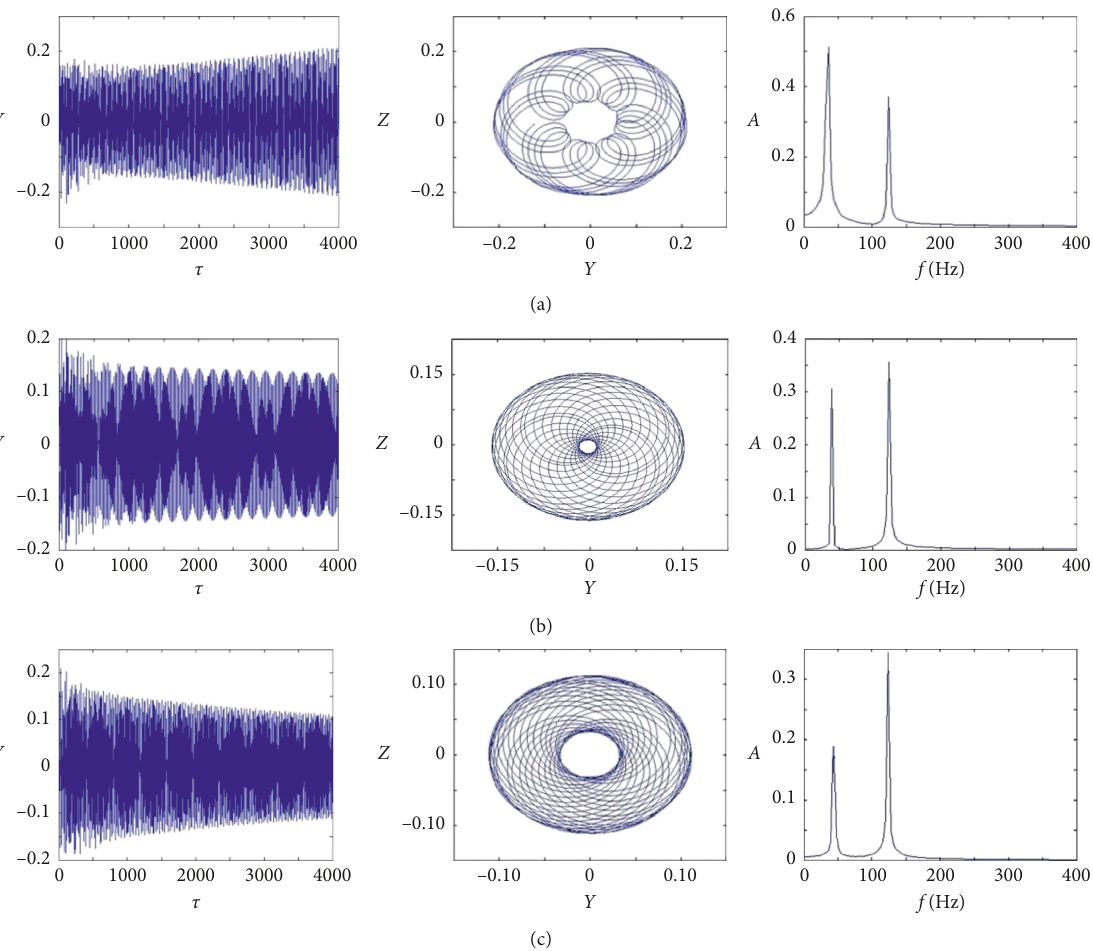
Figure 12: Rotor responses of time domainat, axis orbit, and spectrum at different second support positions. (a) l � 1 . 2 and (c) l 2